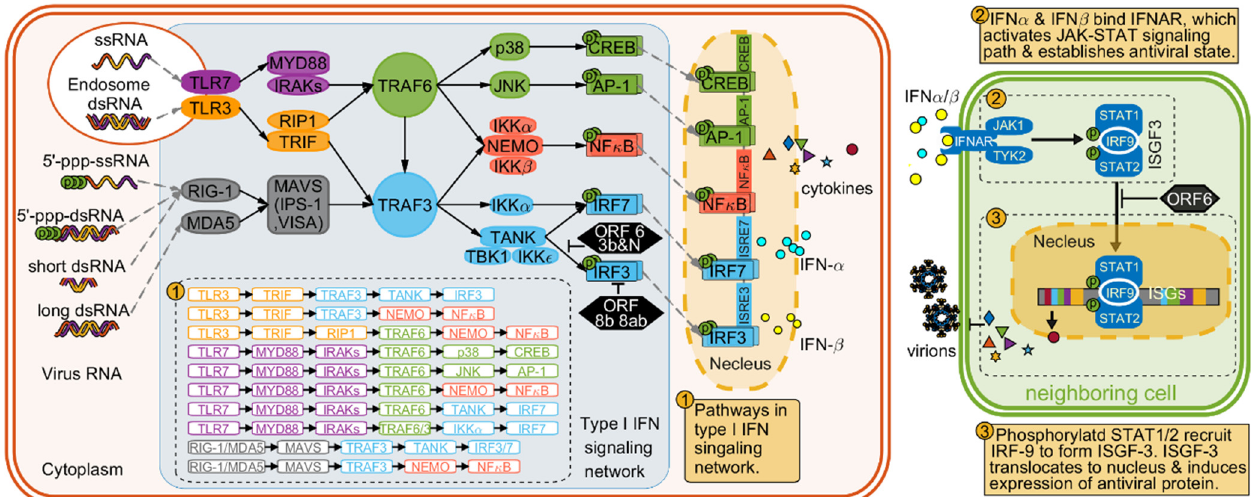
Figure 10. SARS-CoV induced immune response in host cells. Host cell detect virus invasion mainly by TLRs and RIG1-/MDA5 and lead to type I IFN signaling pathway. The receptor IFNAR senses type I IFN and leads to the JAK1-STAT signaling pathway, which expresses antiviral proteins and bring neighboring cell into anti-virus state. The ORF6 suppresses type I IFN expression by inhibiting translocation of STAT1+STAT2+IRF9 complex into nucleus. The ORF 6, 3b, N, and 8b/ab also inhibit the expression of type I IFN by blocking IRF3/7.